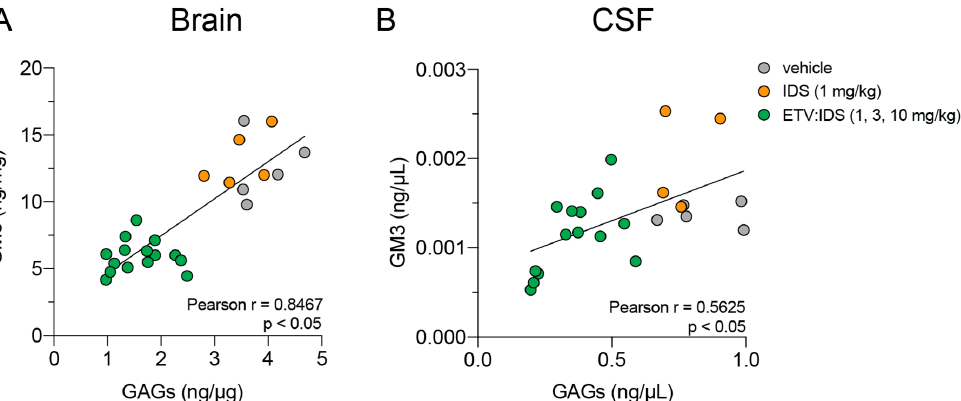
Figure 3. Positive correlation between primary storage substrate (GAGs) and accumulated lysosomal lipids (Ganglioside GM3) in brains and CSF Ids KO;TfR mu/hu KI mice. GAGs and Ganglioside GM3 levels were evaluated in brains ( A ) and CSF ( B ) of Ids KO; TfR mu/hu KI mice treated with increasing doses of ETV:IDS or IDS. The scatter plot was used to determine the correlation between GM3 and GAG levels in brains and CSF. Pearson r was used to determine the correlation coefficient.